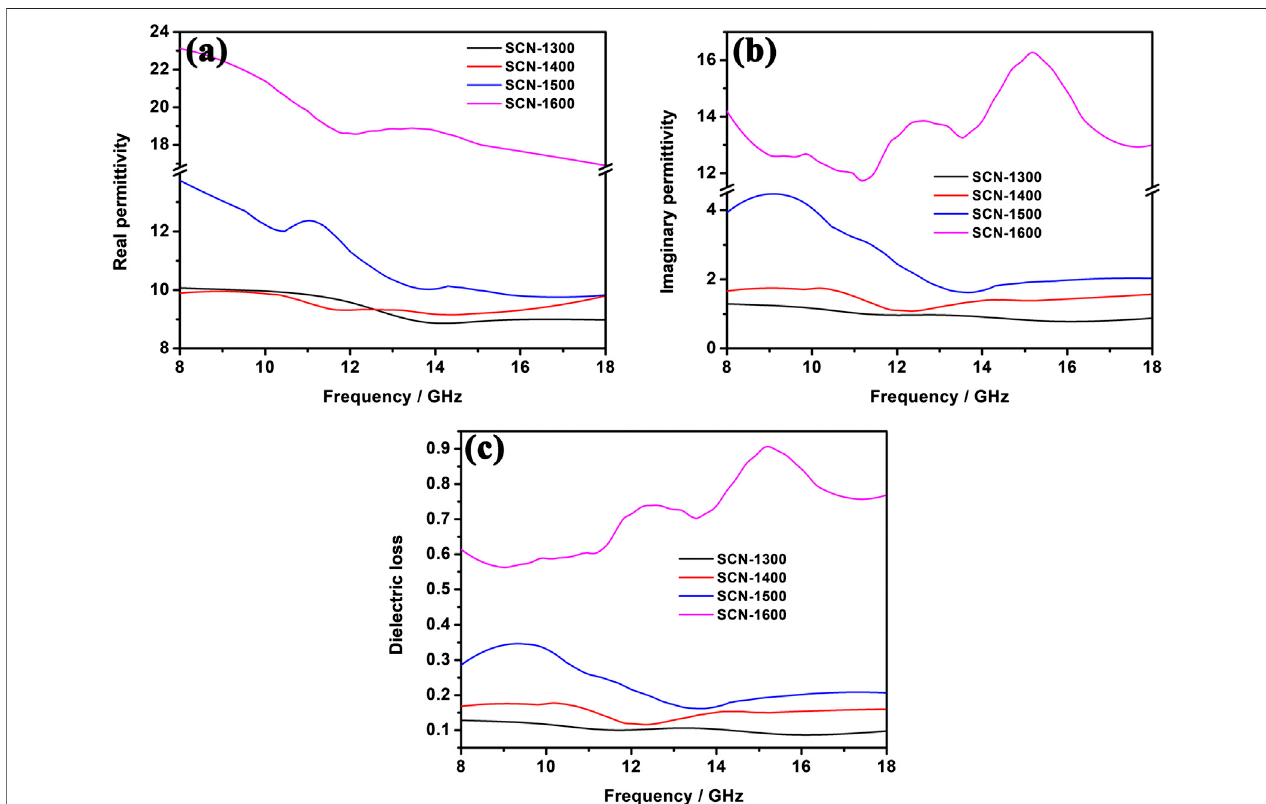
FIGURE 5 | The real (A) and imaginary (B) part of permittivity as well as the dielectric loss (C) at the frequency range of 8 – 18 GHz for SiCN fi bers with different annealing temperatures.